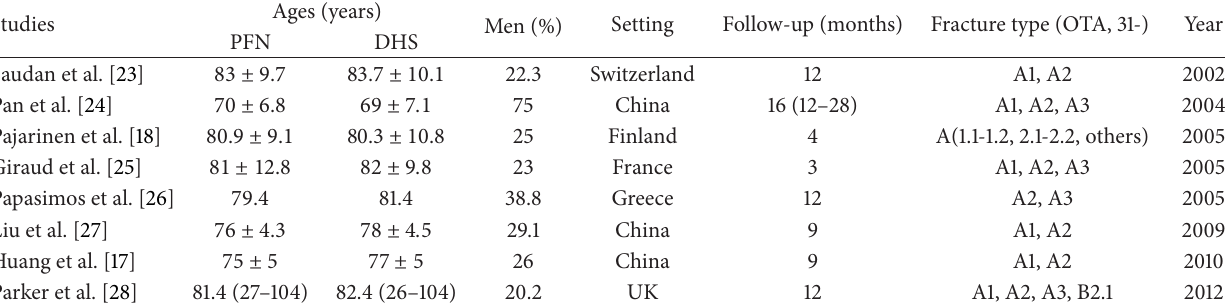
Table 1: Characteristics of the included studies.